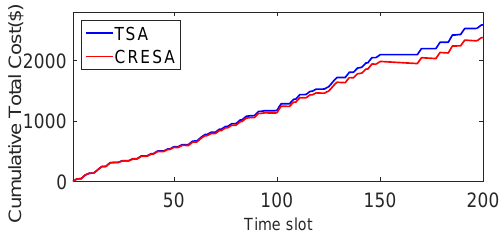
Figure 10. Cumulative Total Cost under cooperative and non-cooperative